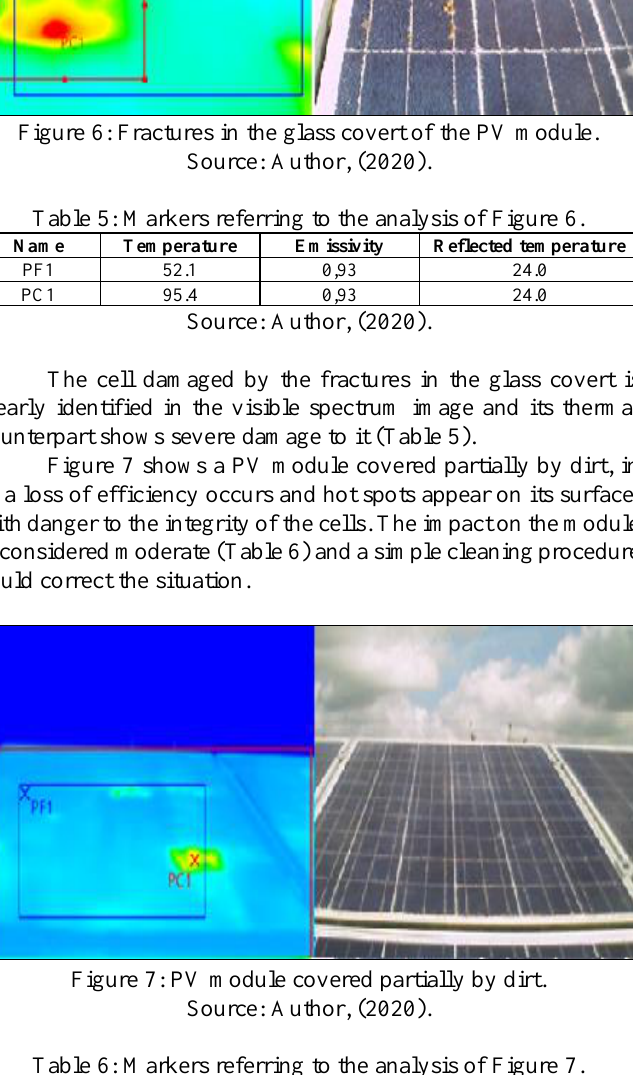
Table 7: Markers referring to the analysis of Figure